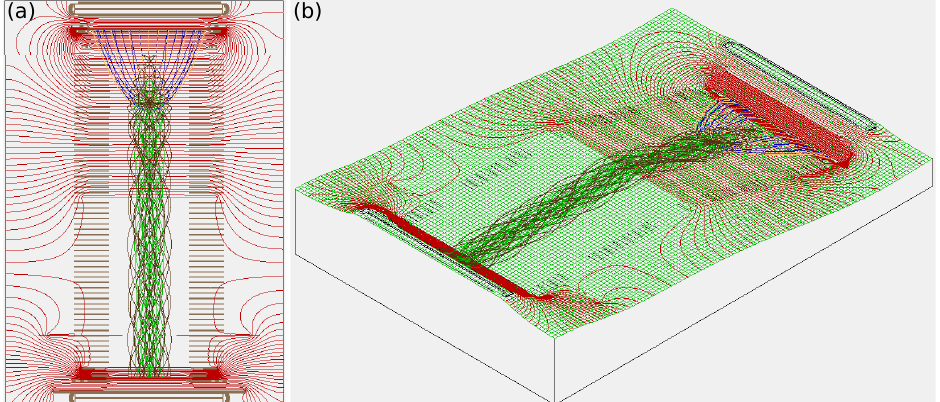
Figure 12. Trajectory simulation for electron–ion coincidence experiments, with electrons detected by the detector equipped to the long arm, and ions to the short arm. The electric field strength is 22 V/cm, and the magnetic flux density is 15.5 Gauss. The trajectories of electrons with kinetic energies of 50 eV and 110 eV are shown in green and brown, respectively. The trajectories of N 2 + with kinetic energy of 45 eV and N 3 + with kinetic energy of 60 eV are shown in orange and blue, respectively. The ejection angles relative to the spectrometer axis range from 0 to 360 degrees. ( a ) Side display of spectrometer equipotential lines (red) and particle trajectories. ( b ) Spectrometer equipotential lines (red) and particle trajectories along the potential energy surface (green).